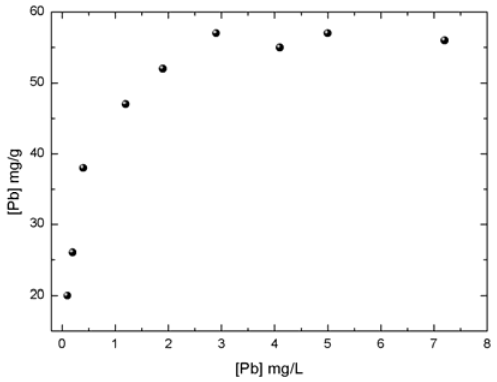
Figure 10. Pb 2+ loading isotherm. Temperature: 288 K. Time: 3 h. Stirring rate: 750 rpm.